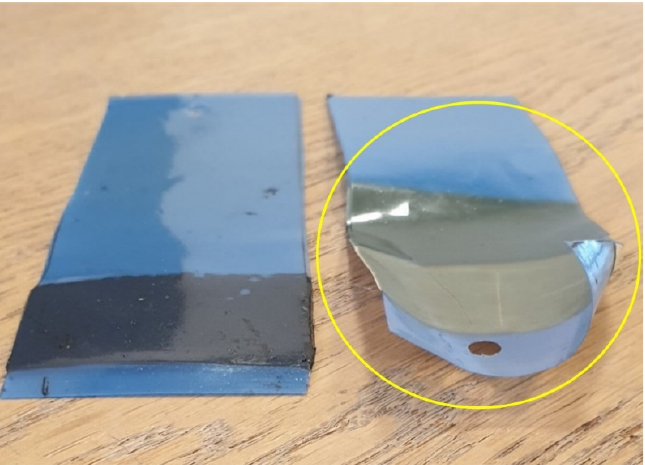
Figure 21. Samples of vapor barrier system T7482-8 after aging for 168 days, assembled with butyl ( left ) and assembled with tape ( right ).